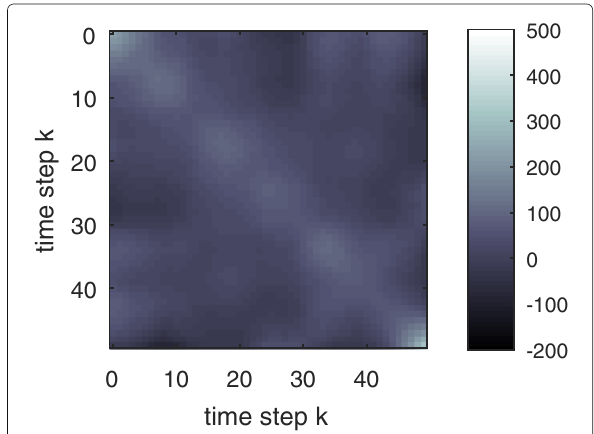
Fig. 14 EnKF (20 members) position covariance matrix cov ( x i ,x j ) after including all measurements in random order